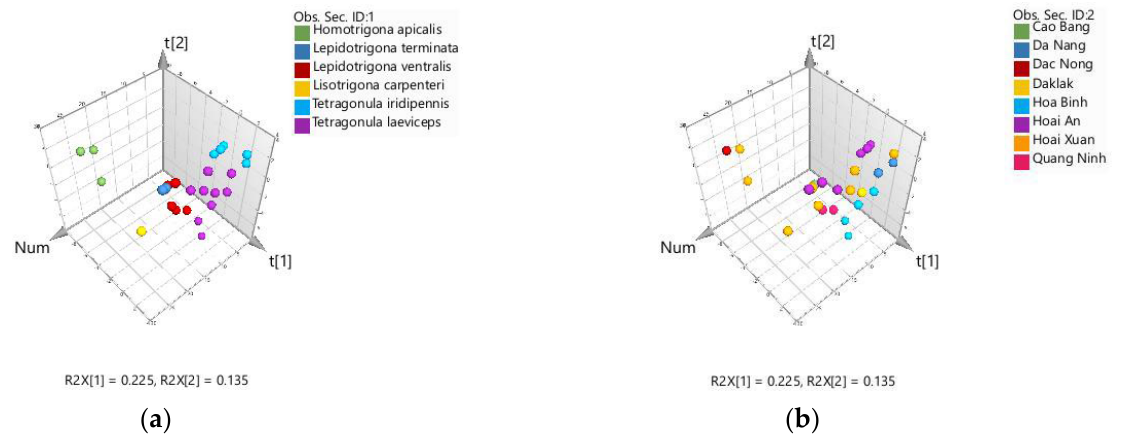
Figure 1. Three-dimensional PCA plots for 25 propolis samples: ( a ) colors correspond to the bee species; ( b ) colors correspond to the location of propolis collection.